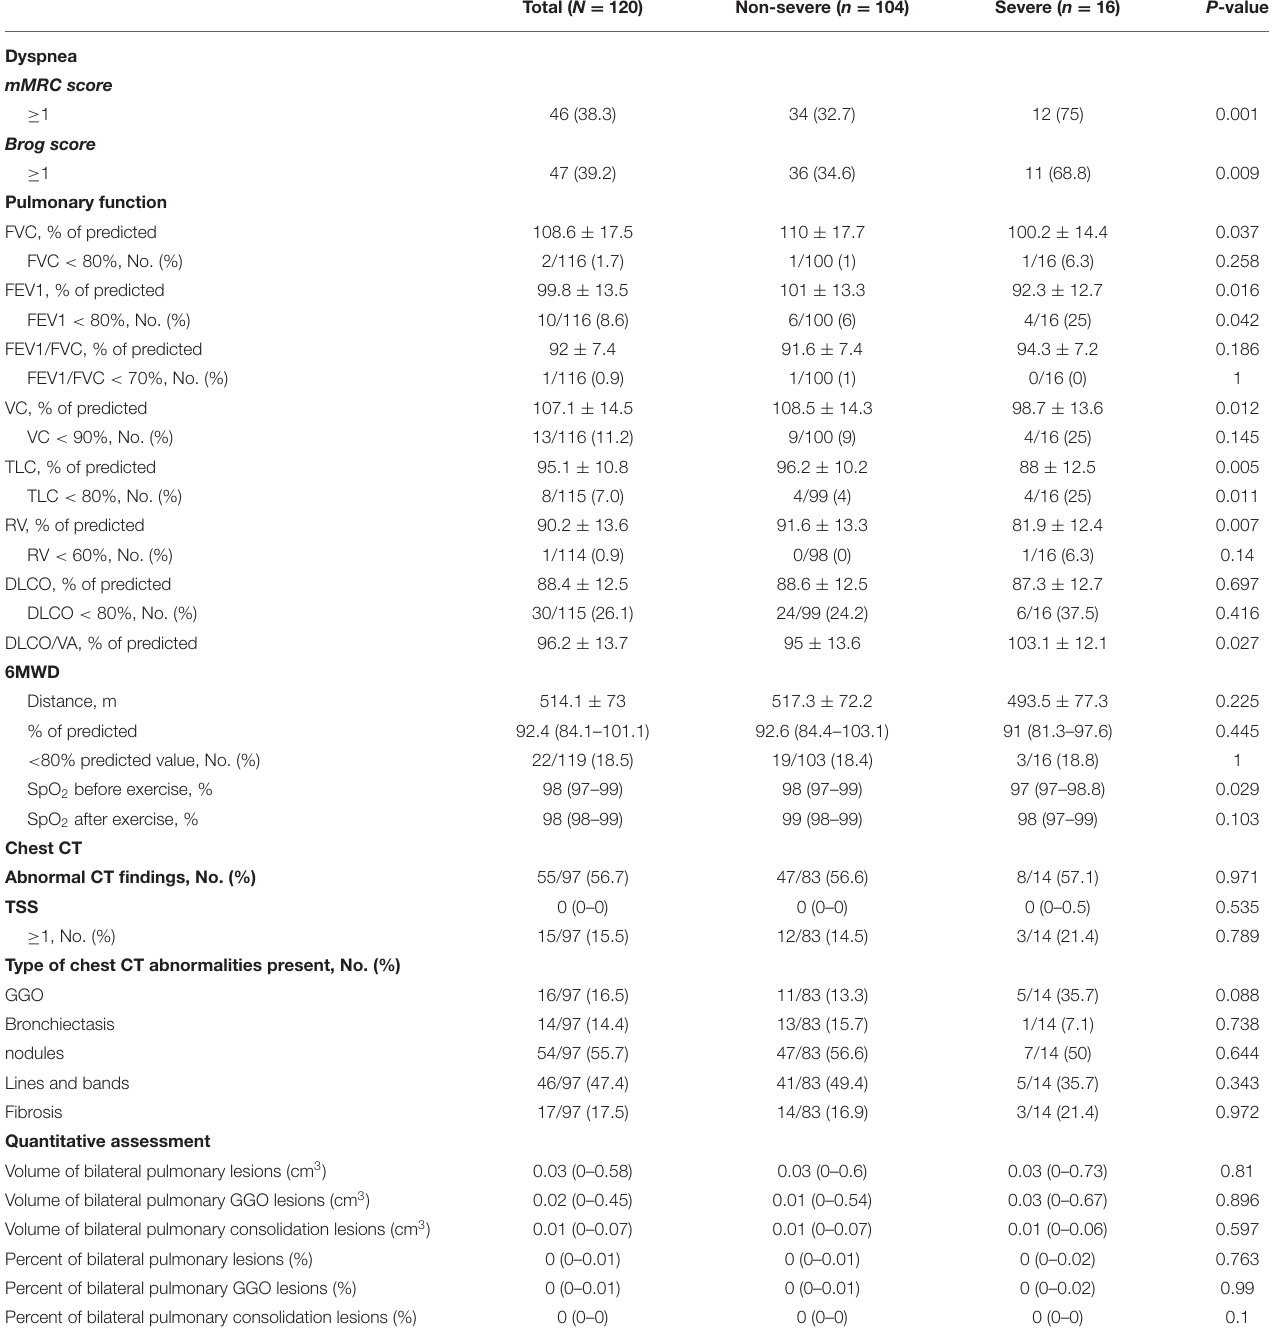
TABLE 4 | Dyspnea, pulmonary function, 6MWD, and chest CT assessment at the nearly 1-year